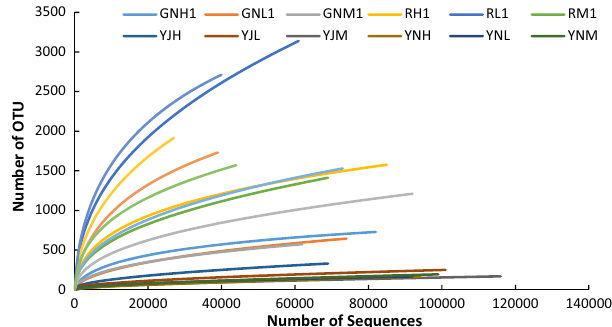
Figure 4. Dilution curve of bacterial 16S gene sequence.